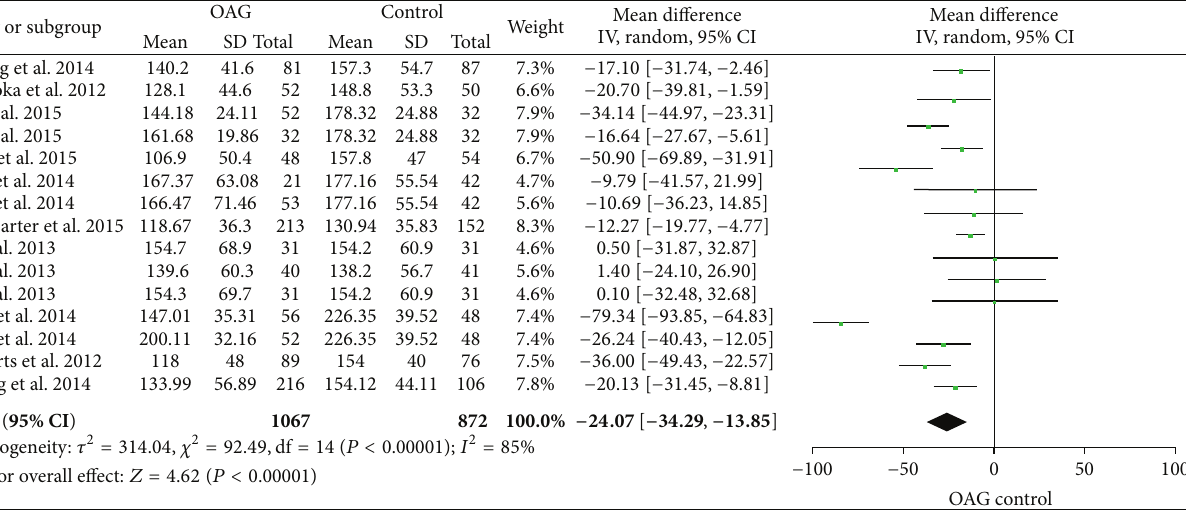
Figure 2: Forest plots of average PPCT between open-angle glaucoma patients and